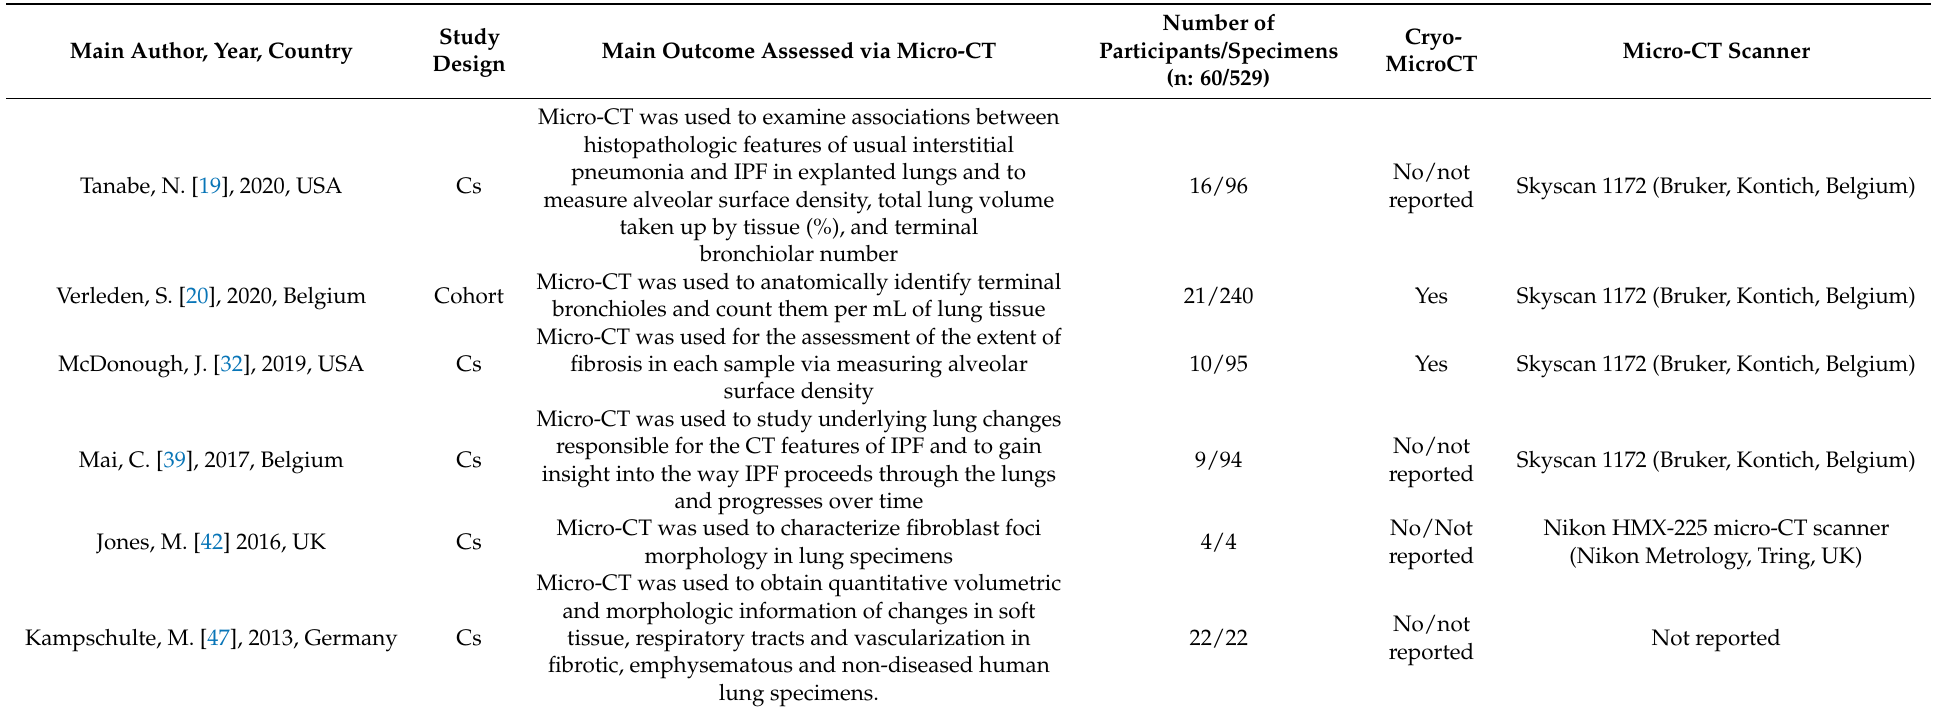
Table 4. Studies using micro-CT for measurement and evaluation of pathological changes in idiopathic pulmonary fibrosis